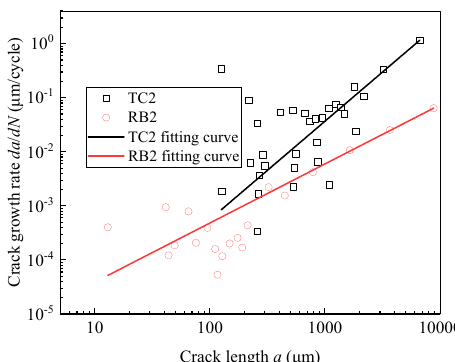
Figure 10. Fitting curve of crack growth rate as function of crack length.